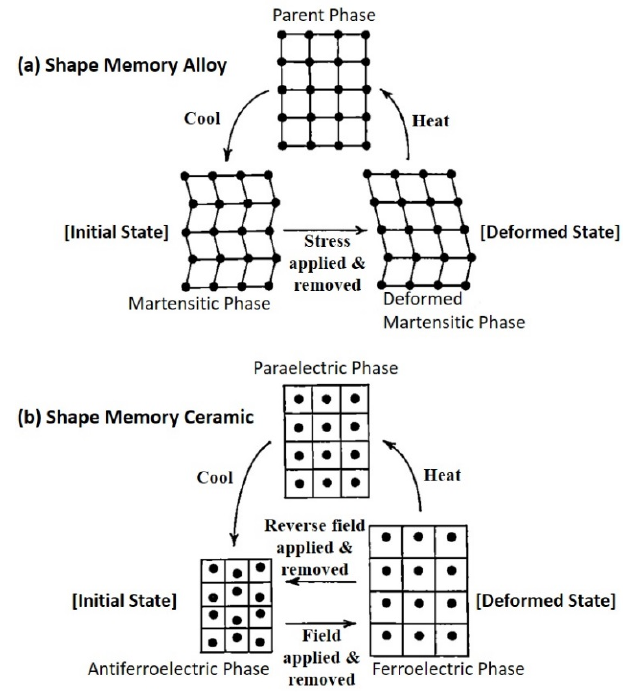
Figure 1. Comparison of the mechanisms for the shape memory effect in alloys ( a ) and in antiferroelectric ceramics ( b ).